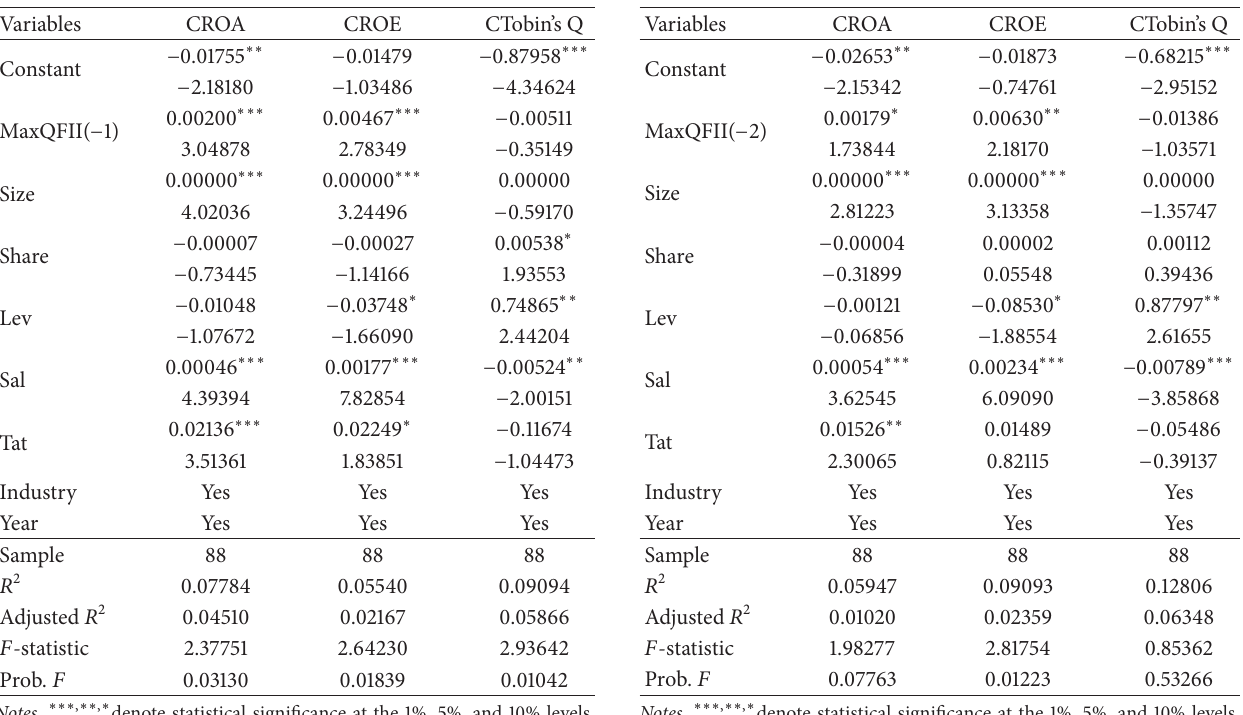
Table 10: Regression results of continuous QFII investment in period ( 𝑡 − 2 ) and performance improvement according to